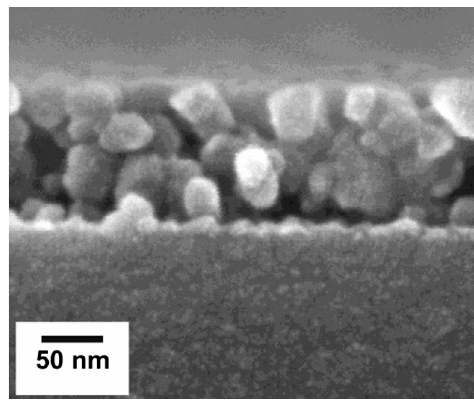
Figure 7. Scanning electron microscopy (SEM) images of MgF 2 films prepared from Mg(OAc) 2 -based precursor solutions. The respective samples have been annealed at 500 °C. Reproduced from Reference [38] with the permission of the Royal Chemical Society.